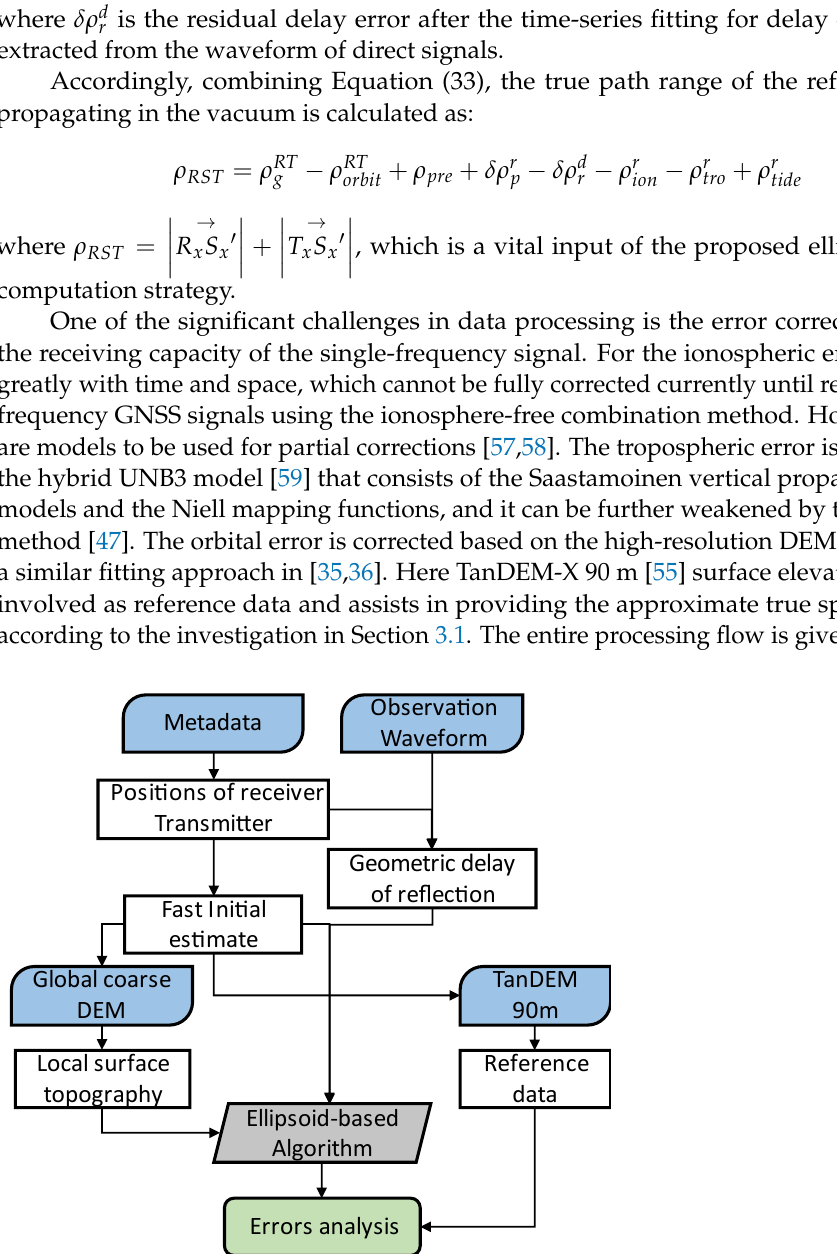
Table 2. Details of methods in the comparison.